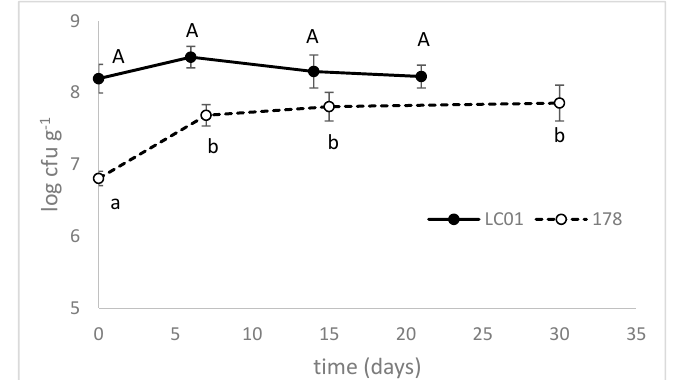
Figure 2. Lactic acid bacteria (LAB) counts, during the ripening of traditional sausages inoculated with Lb. casei LC01 or Lb. plantarum 178. Mean ± standard deviation. The letters indicate statistically significant di ff erences throughout time (one-way ANOVA and Tukey’s test, p < 0.05): small letters, sausages inoculated with Lb. plantarum 178; capital letters, LC01.